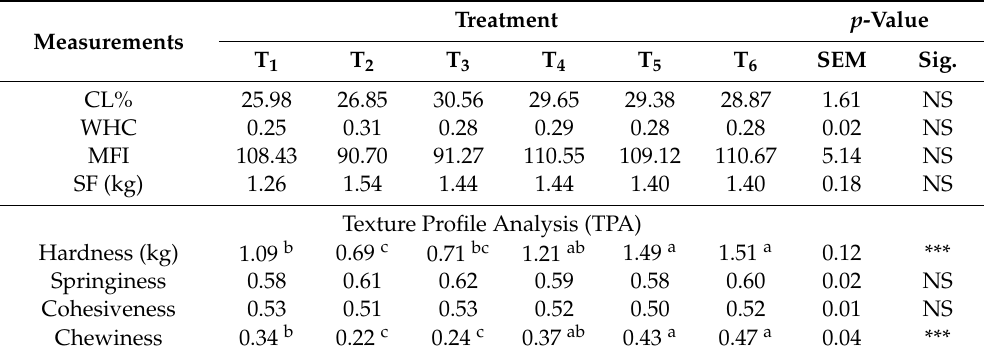
Table 5. E ff ects of some feed additives on the meat characteristics of broilers challenged with C. perfringens during a feeding trial